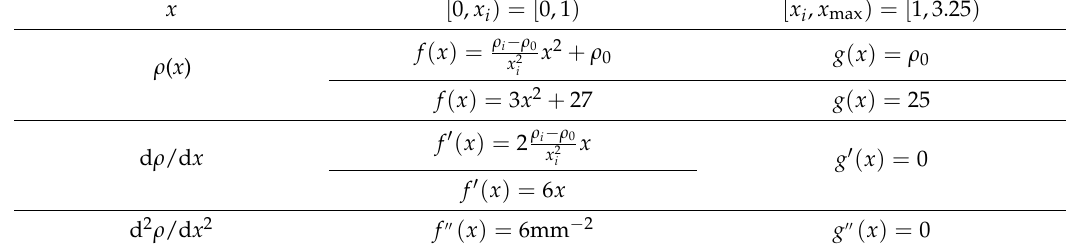
Materials 2019 , 12 , x FOR PEER REVIEW 12 of 22 for the sample pressed at 900 °C (30 °C below the normal temperature). ( c1–c3 ), Group N: for the sample pressed at the normal temperature of 930 °C, prescribed by the manufacturer.